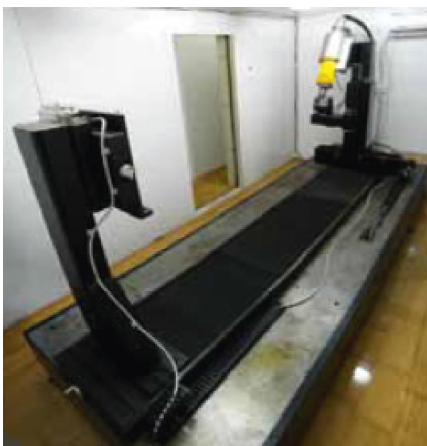
Figure 2: Miro-CT measurement system.